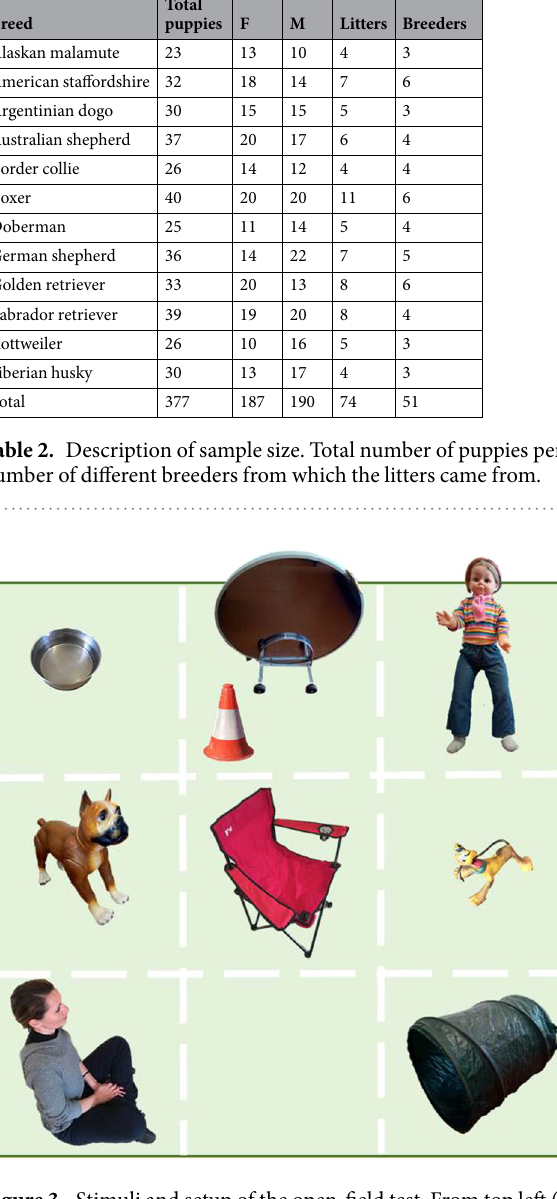
Figure 3. Stimuli and setup of the open-field test. From top left (1) a bowl with water; (2) a street cone and a mirror placed at puppy height; (3) a child-looking doll standing up (approx. 86 cm high); (4) a realistic looking plastic dog (approx. 50 cm tall, boxer type), displaying an erect posture; (5) the breeder seated on a chair; (6) a squeaky dog toy; (7) a female researcher (unfamiliar to the dog) seated on the ground; (8) this square was left empty; (9) a small nylon tunnel (53 cm long and 43 cm diameter) with a small piece of food placed inside. Objects are not to